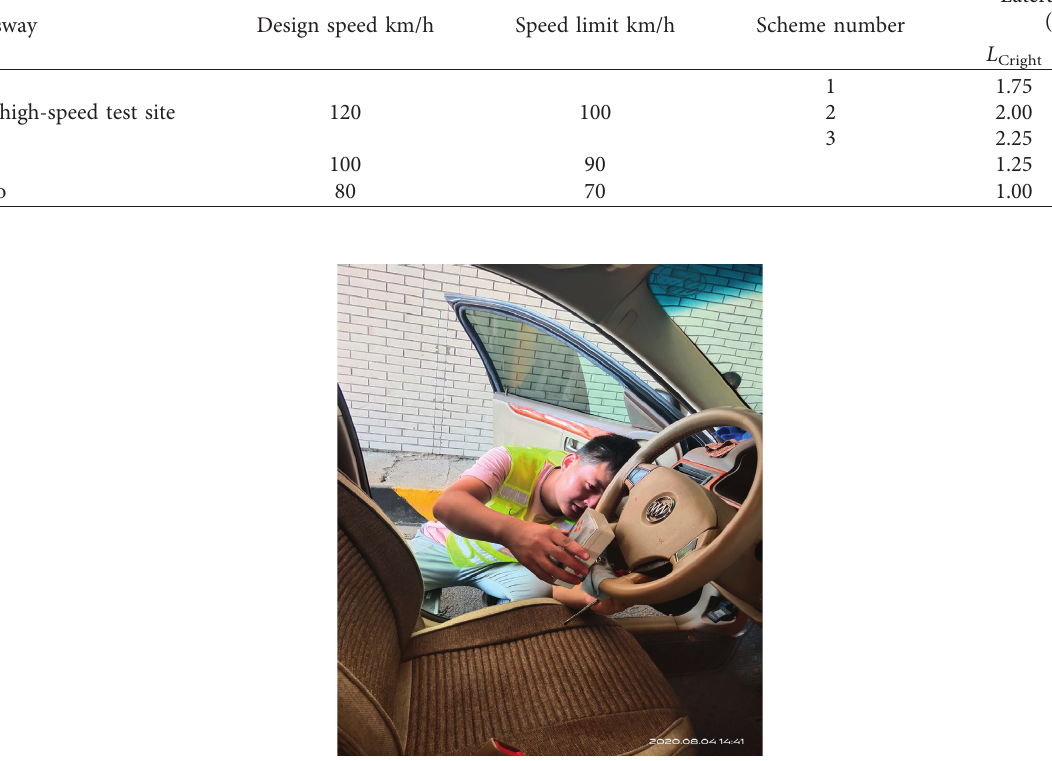
Figure 1: Equipment